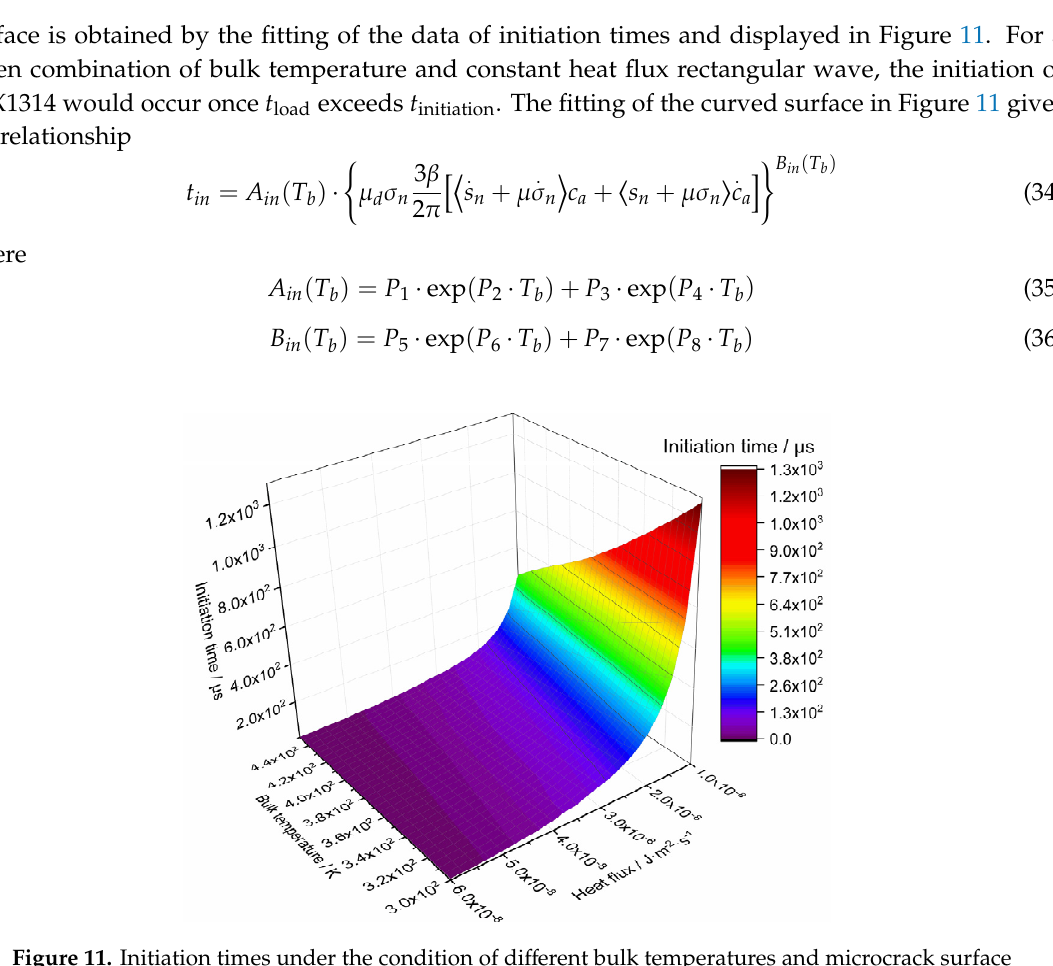
Figure 11. Initiation times under the condition of different bulk temperatures and microcrack surface heat flows. Table 2. Coefficients of the initiation time surface.